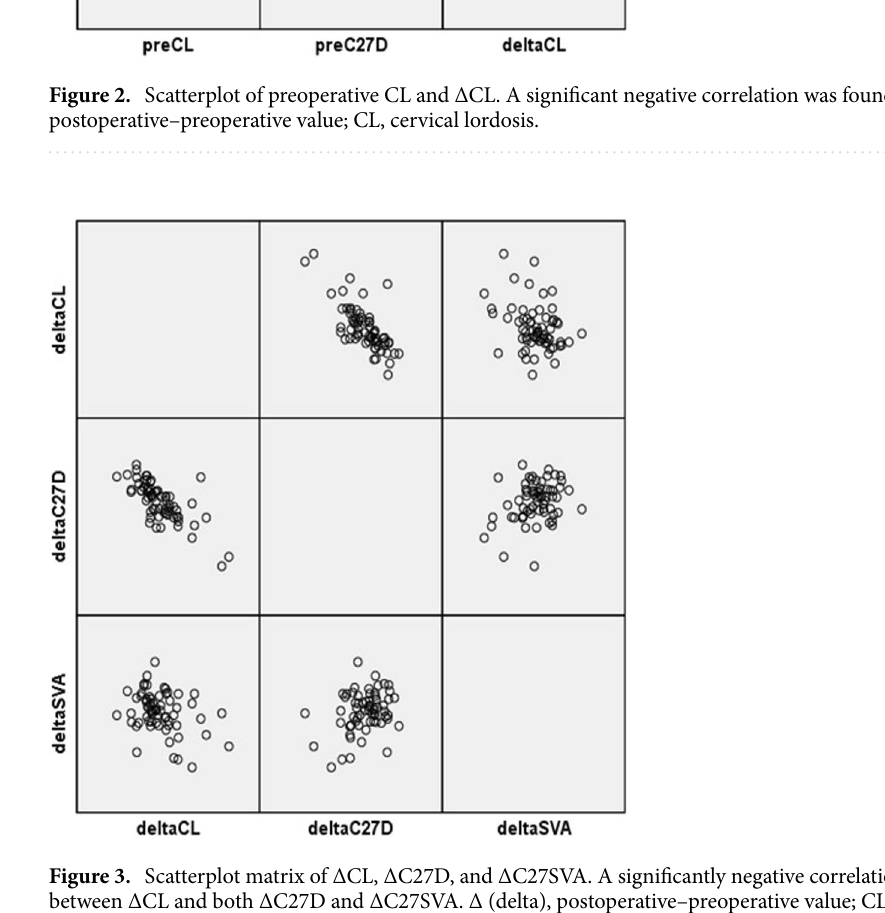
The suboccipital muscles are a group of four muscles, located below the occipital bone, and involved in the extension and rotation of the occipitocervical junction. These include the rectus capitis posterior major, rectus capitis posterior minor, obliquus capitis superior, and obliquus capitis inferior. To assess the overall length of suboccipital muscles, we have measured the OC2D. Spinalis cervicis originate from the spinous process of C7 and attach to the spinous process of the axis, forming the lower part of the ligamentum nuchae. Splenius cervicis,